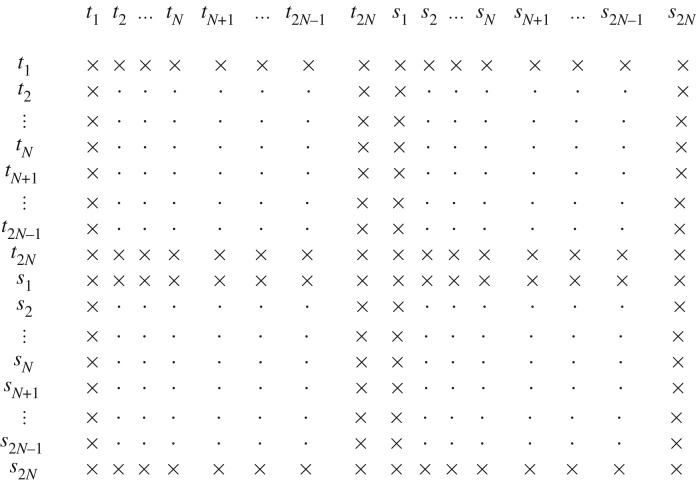
Schematic diagram depicting the removal (×) of rows and columns from H stemming from the imposition of certain boundary conditions.